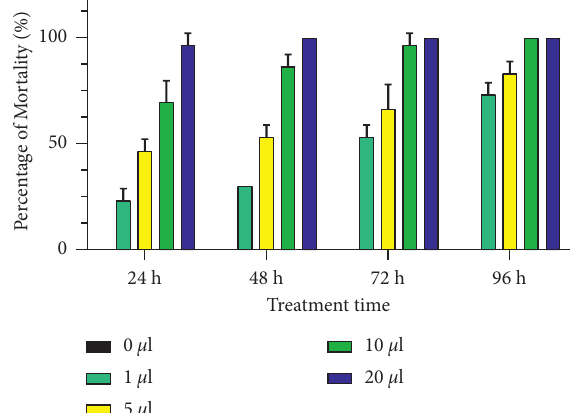
Figure 8: Mortality rate of Callosobruchus maculatus Fab. adults exposed to the contact test of Artemisia herba alba L. essential oils.